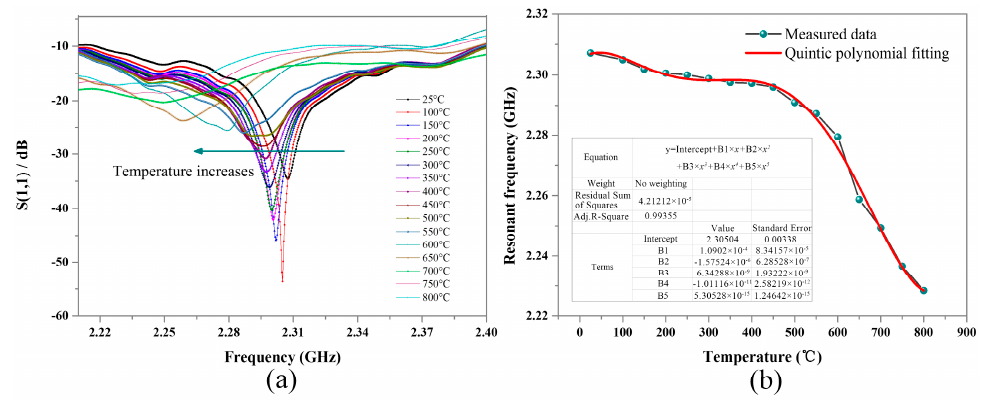
Figure 7. Measurement results for the temperature sensor. ( a ) The measured curves for frequency versus S(1,1). ( b ) The measured temperature versus extracted resonant frequency.